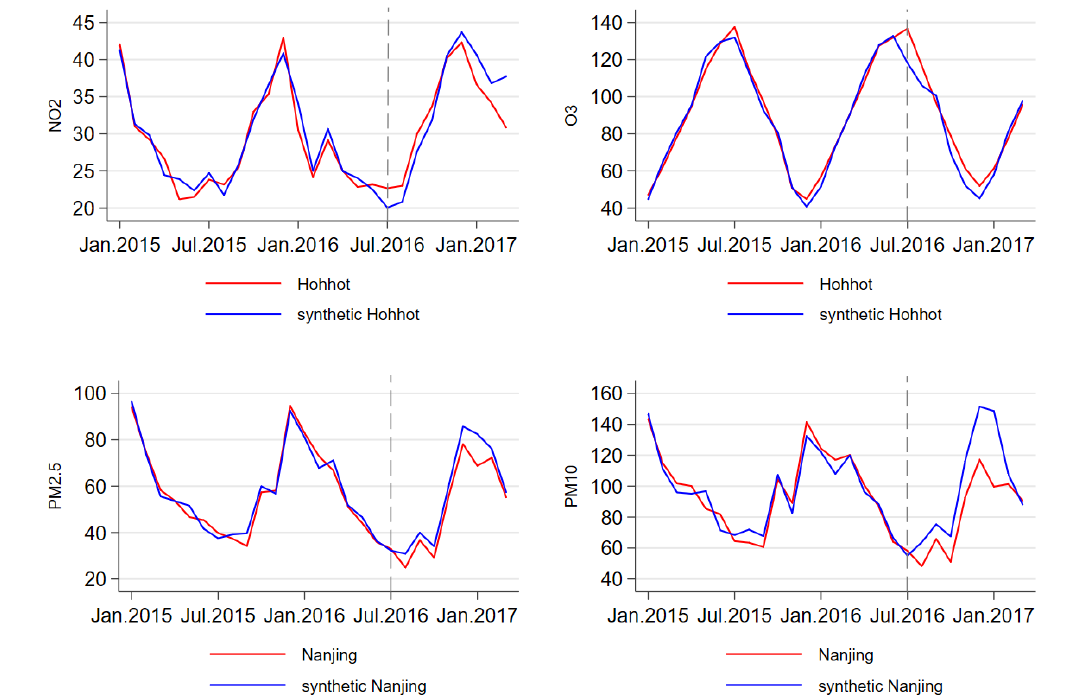
Figure 7. Individual pollutants in treatment regions and synthetic